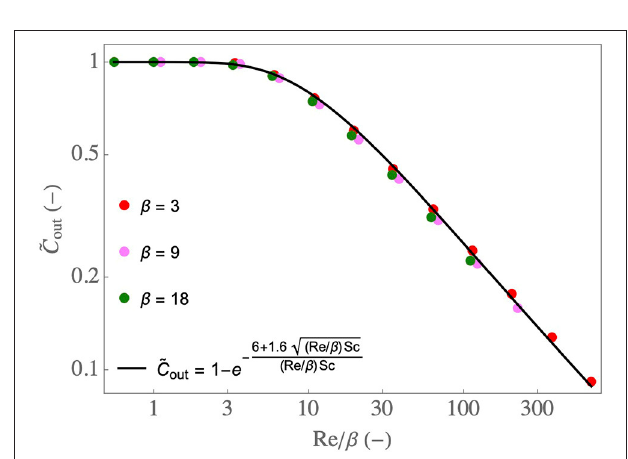
0.4 Re Sc /β . (B) Sh as a function of Re, for various β . + p